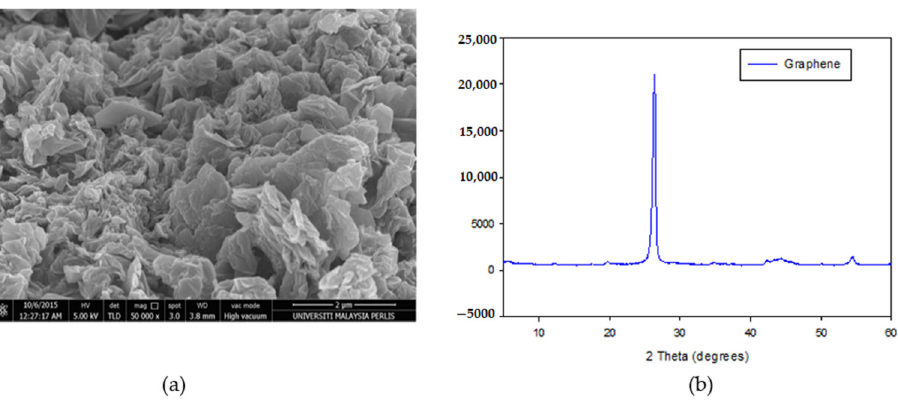
Figure 9. Characterization of Graphene ( a ) FESEM images (50,000 times of magnifying), ( b ) XRD pattern.